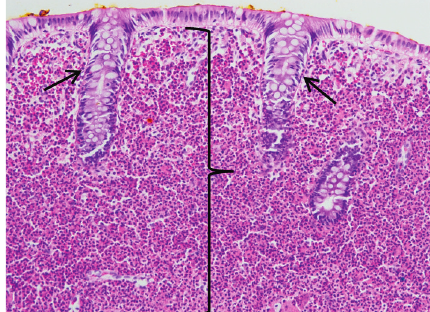
Figure 1: Medium power H&E of the colonic mucosa demon- strating a diffuse expansion of the lamina propria by eosinophils (denoted by black bracket). There is displacement of the colonic crypts (black arrows). No other inflammatory cell types are seen.